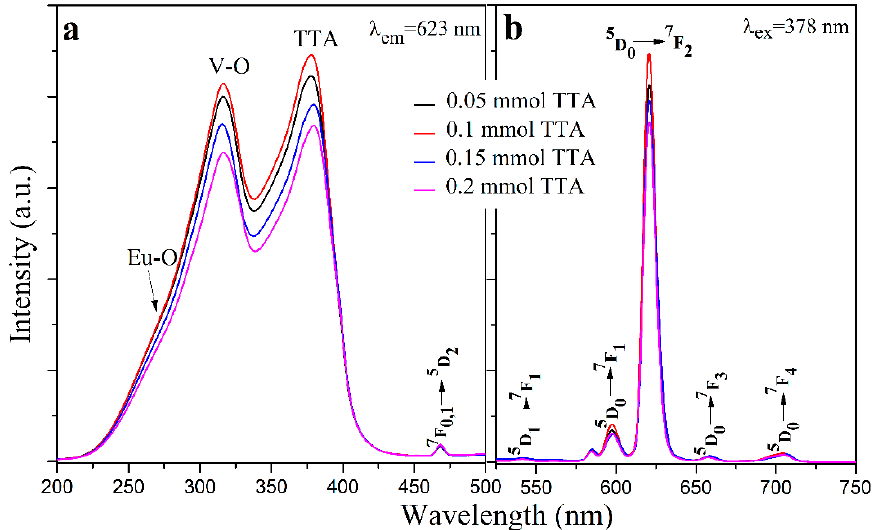
Figure 8. The photoluminescence excitation ( a ) and emission ( b ) spectra of YVO 4 :Eu 3+ @YVO 4 :Eu 3+ –TTA inorganic–organic hybrid nanoparticles prepared with different TTA amounts.